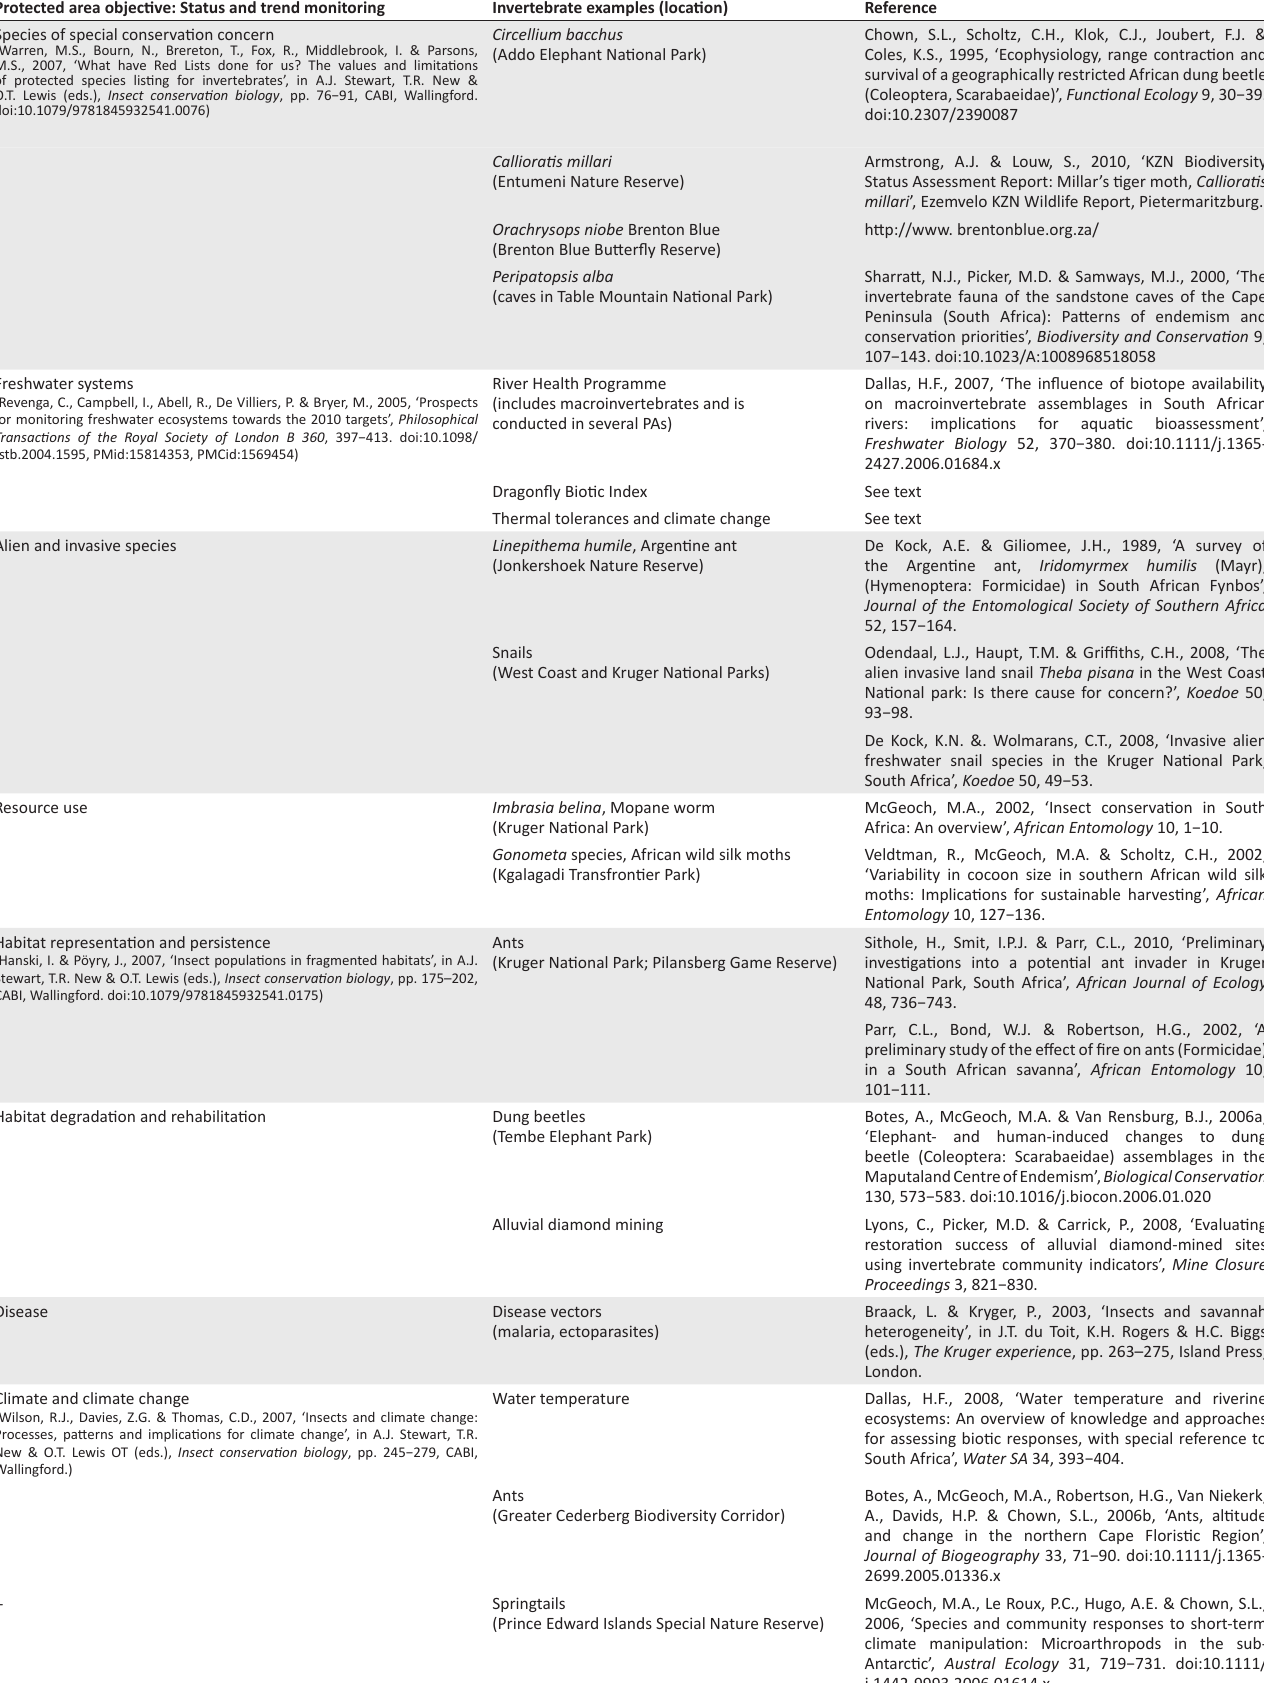
TABLE 1: Examples of biodiversity objectives in protected areas (see McGeoch, M.A., Dopolo, M., Novellie, P., Hendriks, H., Freitag, S., Ferreira, S., et al ., 2011, ‘A strategic framework for biodiversity monitoring in SANParks’, Koedoe 53(2), Art. #991, 10 pages. doi:10.4102/koedoe.v53i2.991) and relevant associated invertebrate monitoring. Protected area objective: Status and trend